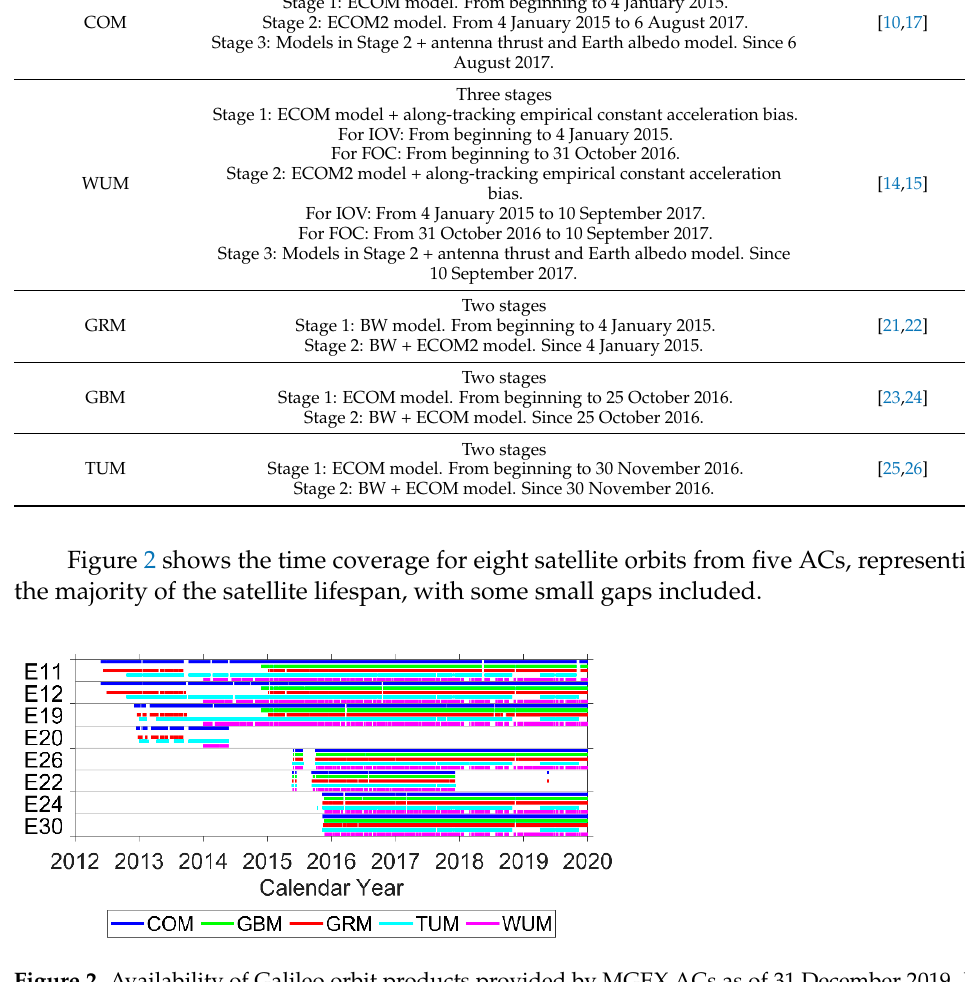
Figure 2. Availability of Galileo orbit products provided by MGEX ACs as of 31 December 2019. No orbit product of E20 was provided by GBM.